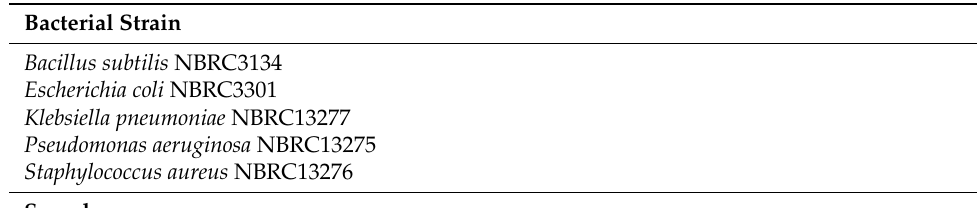
Table 5. Used bacterial strains and samples.